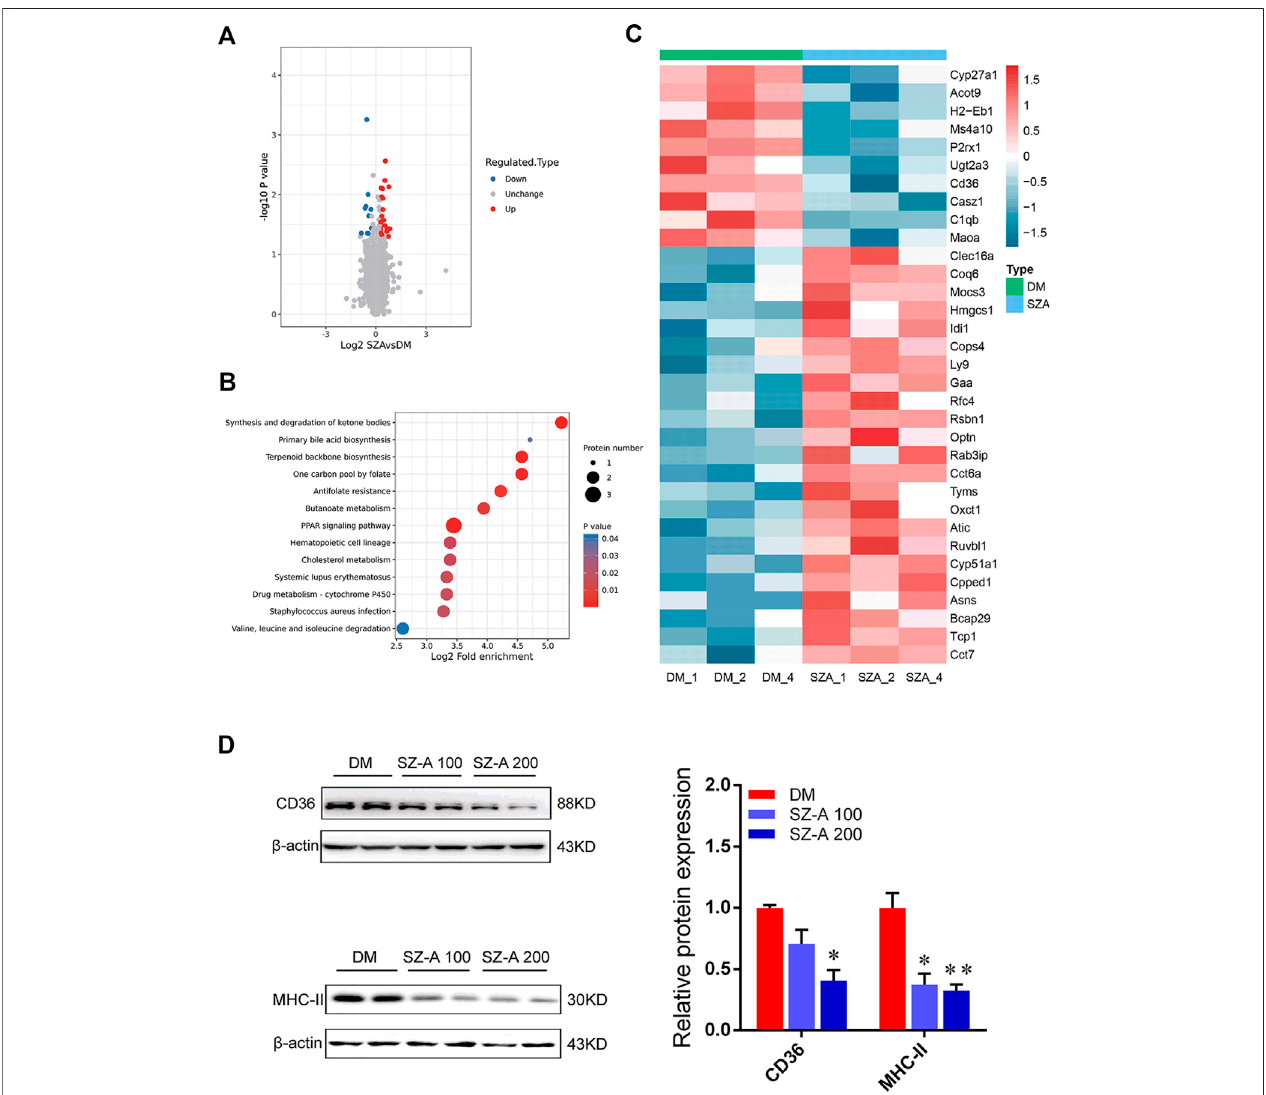
FIGURE 6 | Functional enrichment analysis of differentially abundant proteins in the ileum tissues of KKAy mice after long-term SZ-A treatment. (A) Volcano plot shows the differentially abundant proteins in the ileum of SZ-A-treated group (FDR < 0.01). Signi fi cantly differentially abundant proteins were color-coded: red indicates upregulatedproteins,blueshowsdownregulatedproteins.Twoclustersconsistingof24upregulatedand10downregulatedproteins. (B) Bubblediagramofenrichment ofdifferentiallyabundantproteinsinKEGG.Theresultsofthe fi rst20classi fi cationswiththemostsigni fi cantenrichmentweregiveninthebubblediagram( p < 0.05). (C) TheheatmapfromthreeindependentproteomicanalysesoftestesfromtheDM andSZAgroup. (D) Validatedthedownregulatedproteins inileumofDMandSZ-A- treated groups by Western blotting. CD36 and MHC-II protein abundant levels. The blots shown were representative images. Data are mean ± SEM, n (cid:1) 6. * p < 0.05, ** p < 0.01 vs . DM. DM, diabetic model group, SZA, SZ-A-high-dose-treated group.